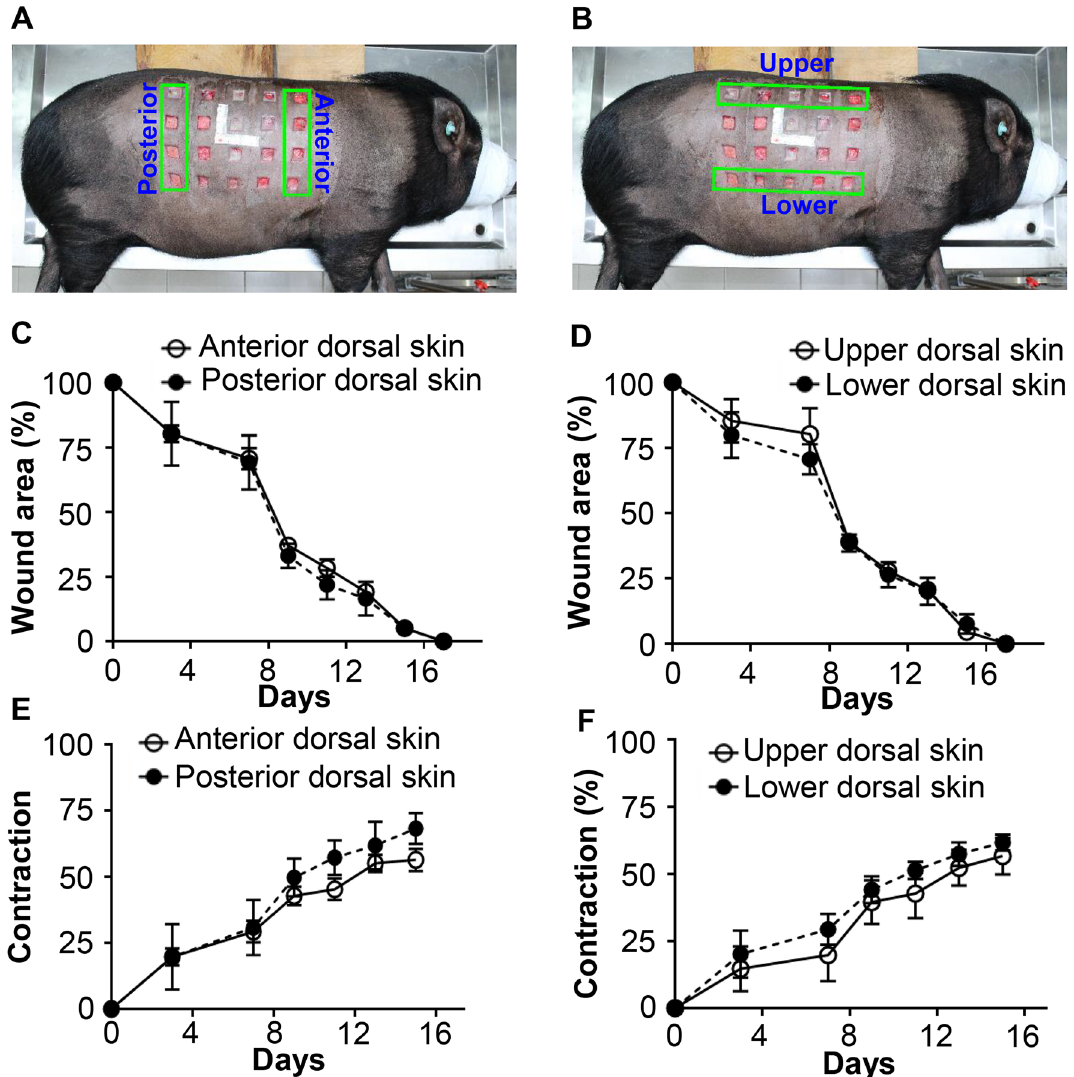
Figure 3. Variations in open wound closure and contraction, based on different regions of the dorsal skin. A wound array of 20 full-thickness wounds (2.5 cm × 2.5 cm × 0.6 cm) was created at different regions of dorsal skin as indicated in ( A , B ). ( A ) Photo presentation of wound regions at the anterior and posterior dorsal skin of a Lanyu pig. ( B ) Photo presentation of wound regions at the upper and lower dorsal skin of a Lanyu pig. ( C , D ) are changes in wound areas at different regions along with time. Data are presented as the percentage of wound area when compared with original wound sizes. ( E , F ) are percentage changes of wound contraction at different regions with time when compared with the original wound sizes. No significant differences between two groups were analyzed using student t-test statistical in the 1 cm-thick area from the midline of the inter-wound area were analyzed, and the ROI for 1 cm distance of inter-wounds were the highest and subsided along with increased inter-wound distance. The ROI for 4, 5 and 6 cm inter-wound distances reached the background, indicating no interference between adjacent wounds, such that they were close to their ROI of the respective original skin. On the contrary, the ROI for 1, 2 and 3 cm inter-wound distances were significantly higher (P < 0.001) than the background and the ROI for 4, 5 and 6 cm inter-wound distances. Wound appearances and laser Doppler images from weeks 0 to 7 are shown in Fig. 4C. Quantification of blood flow signals within wound sites reached the highest values at weeks 2 and 3 and subsequently subsided (Fig. 4C,E). In wounds with shorter inter-wound distances, blood flow signals were maintained significantly higher (P < 0.001) than those with longer inter-wound distances above 4 cm. This distinct phenomenon was observed clearly since week 4 and substantiated at least up to 7 weeks. This result indicated interference among wounds with inter-wound distances below 4 cm (Fig. 4E). Wound closure and contraction were quantified over time (Fig. 4F,G). Wound appearance and wound clo- sure data demonstrated that the wounds were completely closed before week 3 (Fig. 4C,F). Using wound size of 2.5 cm × 2.5 cm, following most reported wound size, inter-wound distance of 1 cm significantly affected the